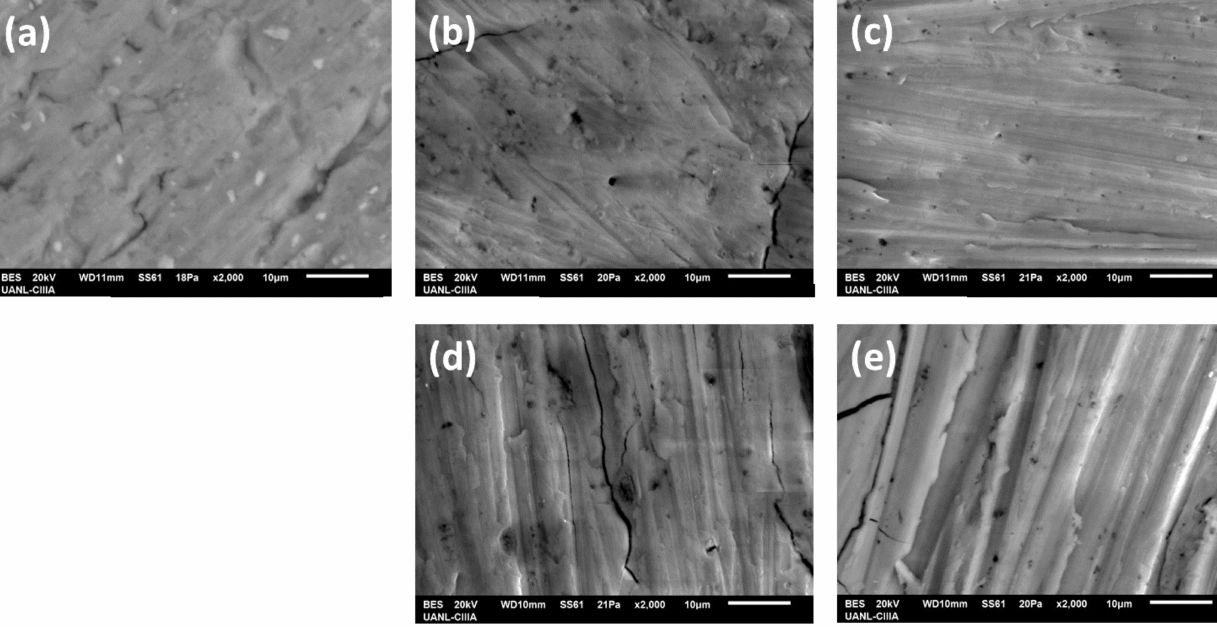
Figure 2. SEM Surface morphology of the AA6061 anodized a 4.5 A/dm 2 in different bath: ( a ) 4.5A C0M S2M, ( b ) 4.5A C1M S5, ( c ) 4.5A C1M S10, ( d ) 4.5A C2M S5 and ( e ) 4.5A C2M